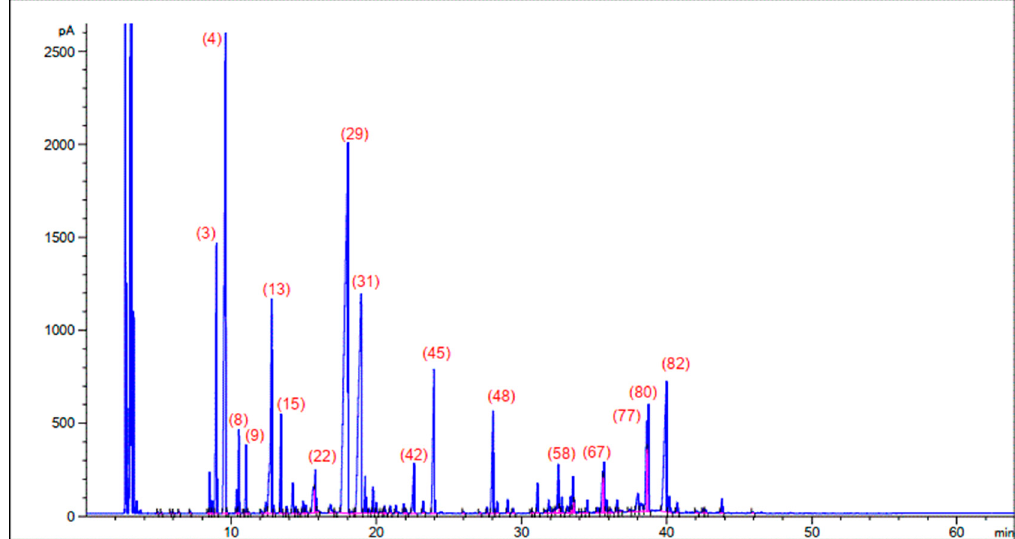
Figure 1. Chromatogram of GC-FID-H-aerial part-HD essential oils of Thymus algeriensis Boiss. The numbers in Figure 1 represent the numbering of the compounds shown in Table 1.